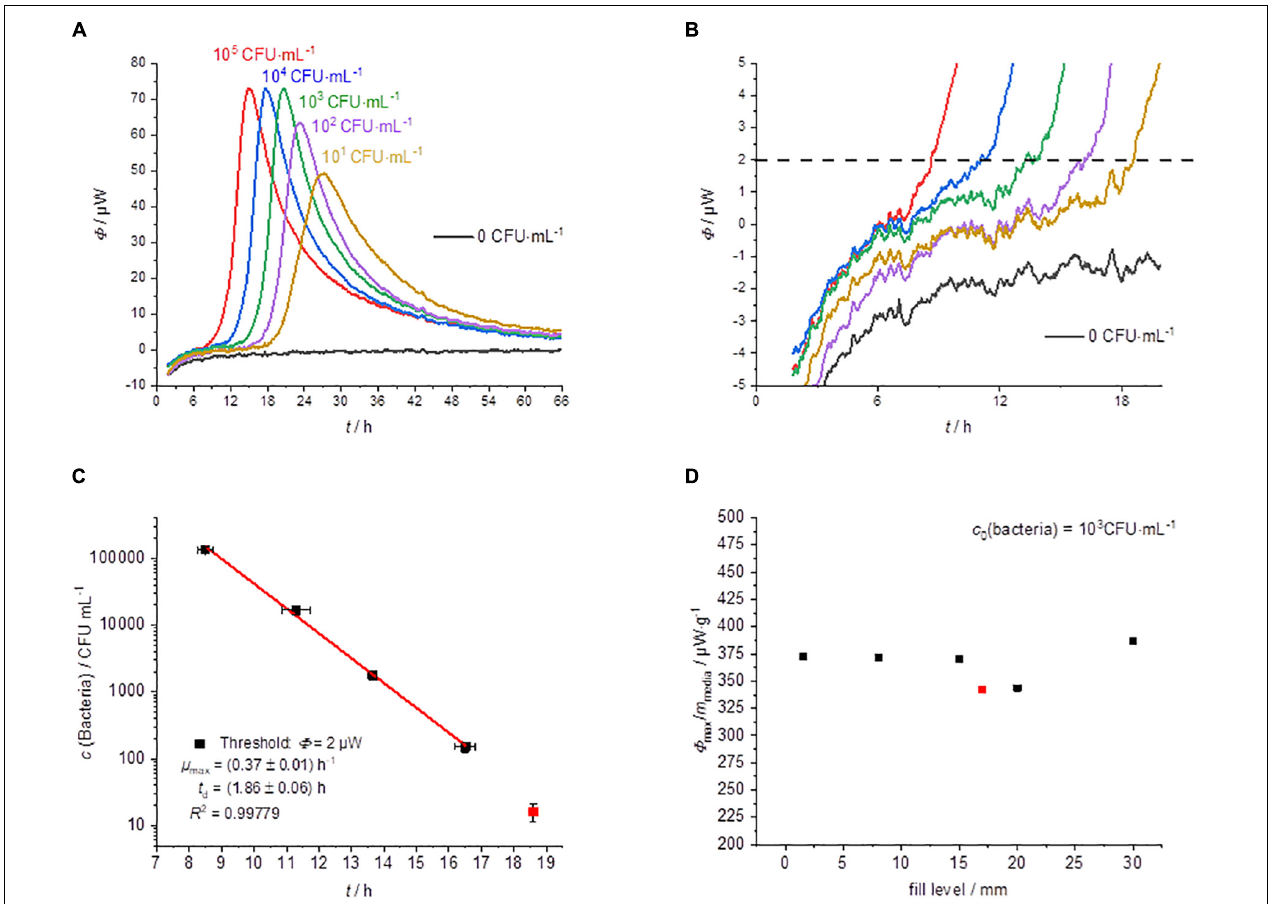
FIGURE 3 | Summary of the IMC experiments performed in MRS-broth (GL). (A) Dependency of the heat traces on the initial bacterial concentration. (B) Detail magnification of the heat signal near the quantification limit, the dotted line represents the postulated threshold value (cid:56) dect . = 2 µ W. (C) Dependency of the detection time on the initial bacterial concentration. (D) Specific maximum heat flow as a function of the filling level of the calorimetric